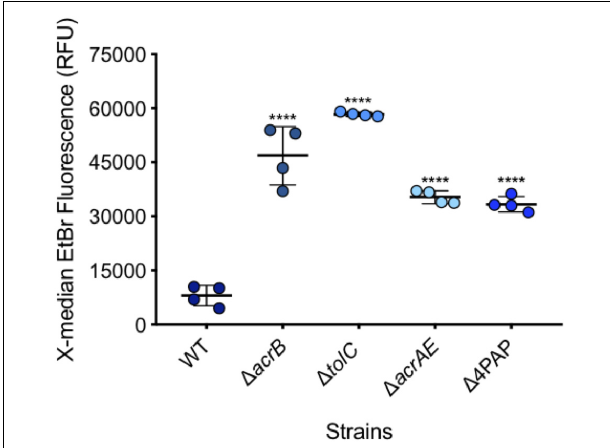
FIGURE 5 | Accumulation of ethidium bromide in WT SL1344 and efflux deficient strains. Single circles represent the X-median value of ethidium bromide fluorescence from 10,000 cells within a biological replicate. 4 biological replicates for each strain are shown, with a long bar to show the mean and standard error of the mean (SEM) error bars. WT had a mean RFU of 8024. This is significantly lower than the mean RFUs of (cid:49) acrB (46824 RFU), (cid:49) tolC (58321 RFU), (cid:49) acrAE (35314 RFU) and D4PAP (33359 RFU). Significance values were based on a one-way ANOVA and Dunnett’s multiple comparison test of all strains compared to WT. All P -values were < 0.0001 which is represented by ∗∗∗∗ above strain plots in this figure.